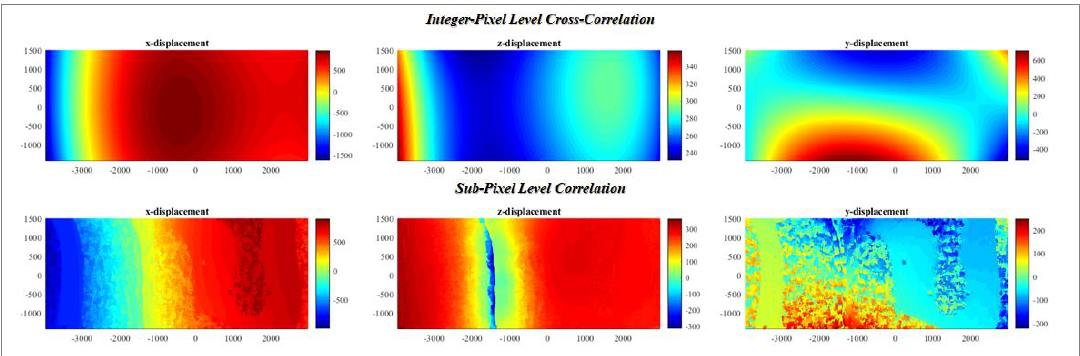
Figure 5. Results of the hDIC calculations after integer-pixel level cross-correlation and sub-pixel level correlation stages represented in the undeformed ROI in units of micron.